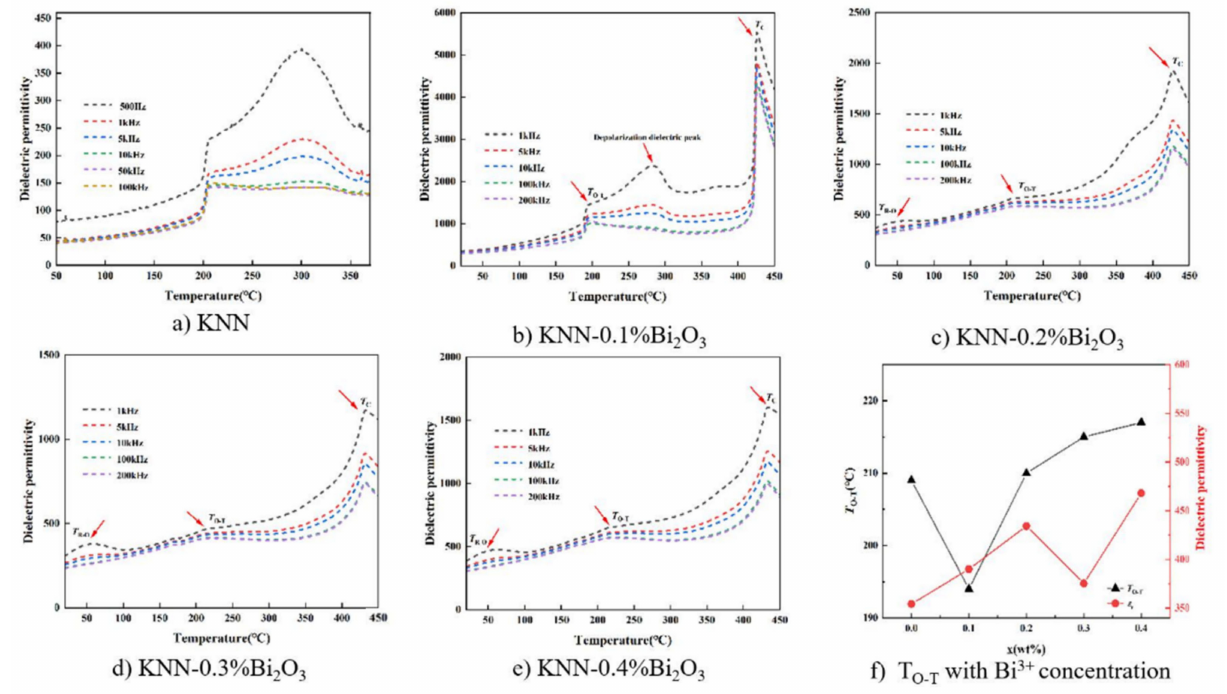
Figure 4. Temperature dependence of dielectric permittivity and T O-T , and dielectric constant ε r dependence for KNN-x%Bi 2 O 3 (x = 0.0, 0.1, 0.2, 0.3, 0.4)